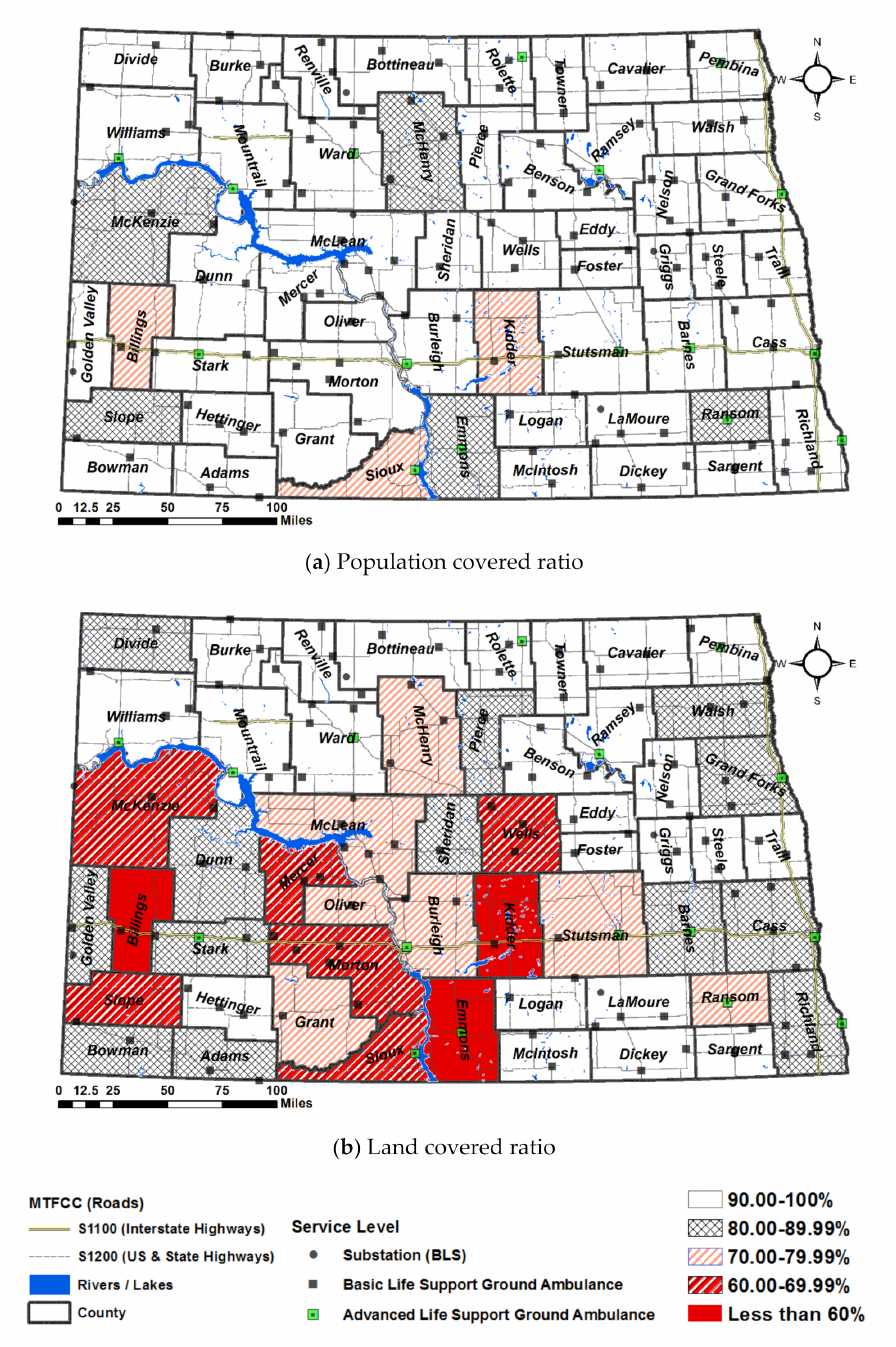
Figure 6. Population covered ratio ( a ) and Land covered ratio ( b ) of Scenario 4. By adopting a new management of chute time and travel speed on roads, Morton County experiences up to 62.32% improvement in population served by the local ambu- lances, thereby covering 92.98% of county population within threshold service response time (Figure 6a). The population covered ratio of Ransom and Emmons Counties